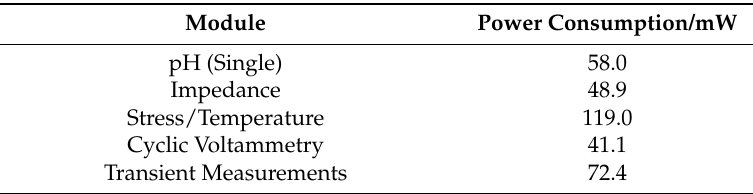
Table 5. Estimated power consumption of the various sensor